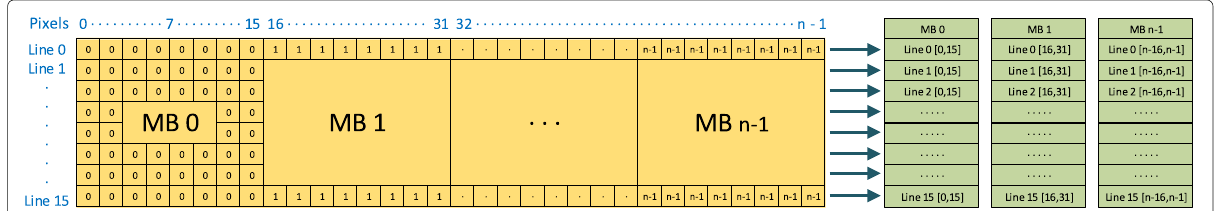
Fig. 6 Custom generator for macroblock check. On the left side, the sorted component input line is shown. On the right side, the expected macroblock output is